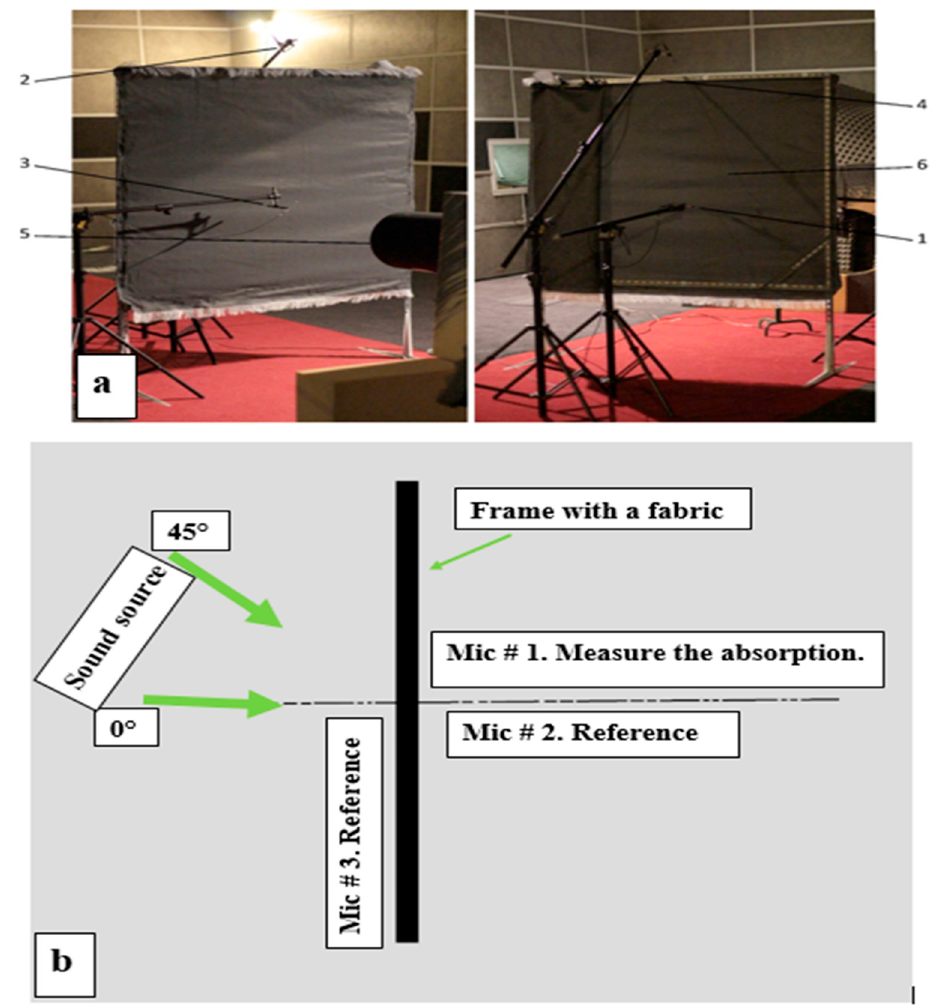
Figure 3. ( a ) Test stand: 1—microphone #1, 2—microphone #2, 3—microphone #3, 4—frame, 5—the sound source, 6—tested fabric; ( b ) Top view of the measurement area.